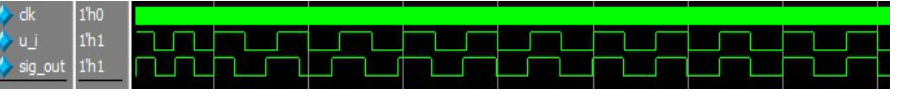
Figure 11. Simulation waveform of frequency-tracking control experiment. 4. Experimental Verification 4.1. Experimental Platform In order to verify the feasibility of the above frequency-tracking control method, Fig- ure 12 is used as an experimental platform for WPT system design. The experimental plat- form mainly consists of a high-frequency power supply, a transceiver coil, an oscilloscope, current probes, a rectifier circuit, and an electronic load. Built into the high-frequency power supply are current and voltage acquisition circuits. The FPGA chip controls the output voltage frequency of the power supply; the operating frequency is 48 kHz at a fixed frequency. Table 1 shows the circuit parameters of the platform.